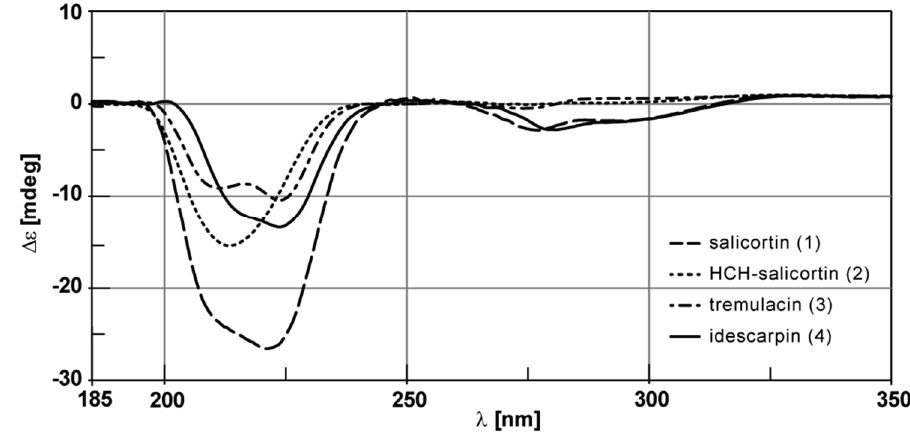
Figure 4. Superimposed CD spectra of isolated salicortin ( 1 ), HCH-salicortin ( 2 ), tremulacin ( 3 ) and idescarpin ( 4